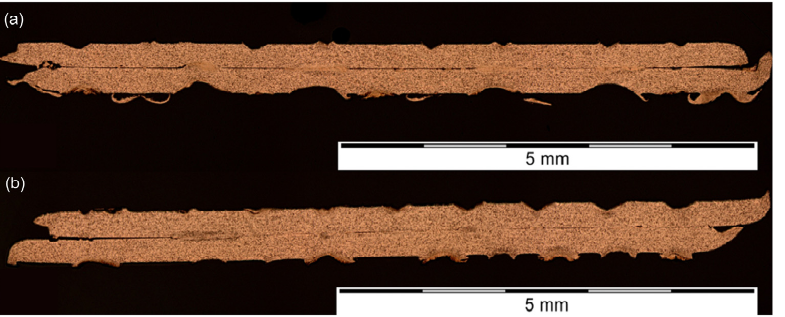
Figure 17. Metallographic images (×50) of etched Cu–Cu welds with t = 0.3 mm for increasing amplitude: ( a ) 50%; ( b ) 70%.